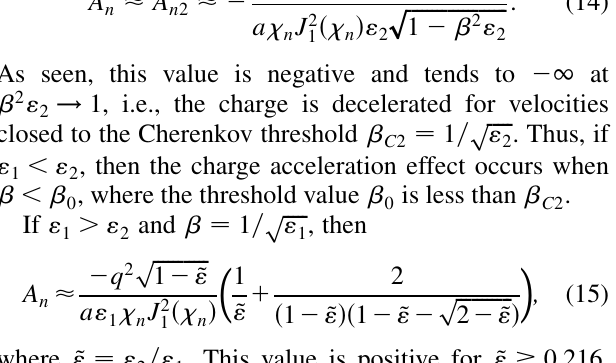
FIG. 2. Poles (crosses), branch points (circlets), branch cuts, and the integration path in a complex plane of ! for integrals in